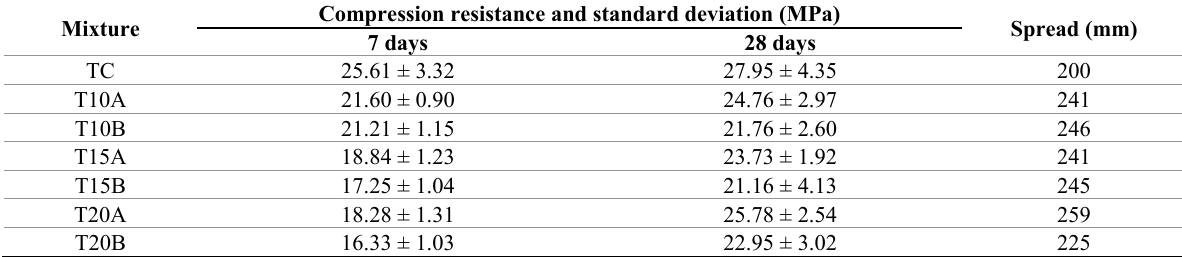
Table 5. Results of compression strength and spread tests of mortars